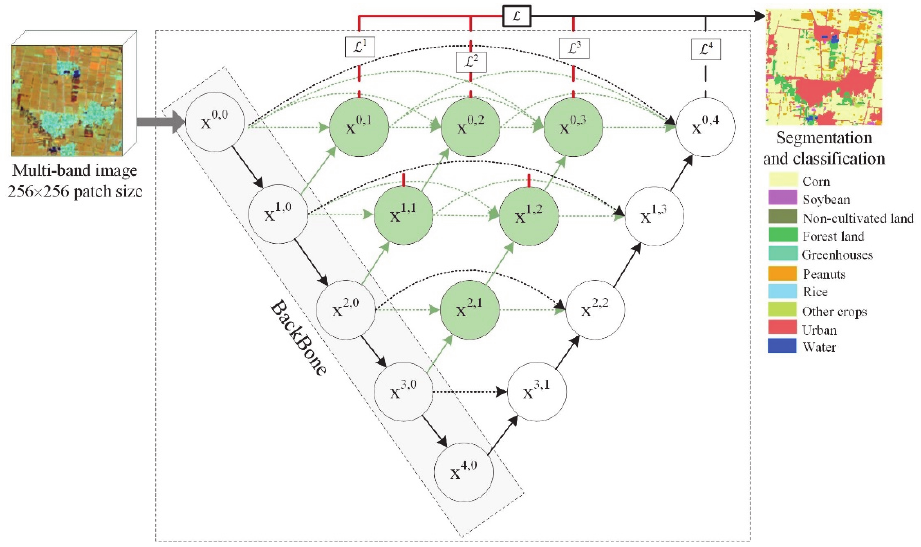
Figure 3. UNet++ architecture used for crop segmentation and classification.